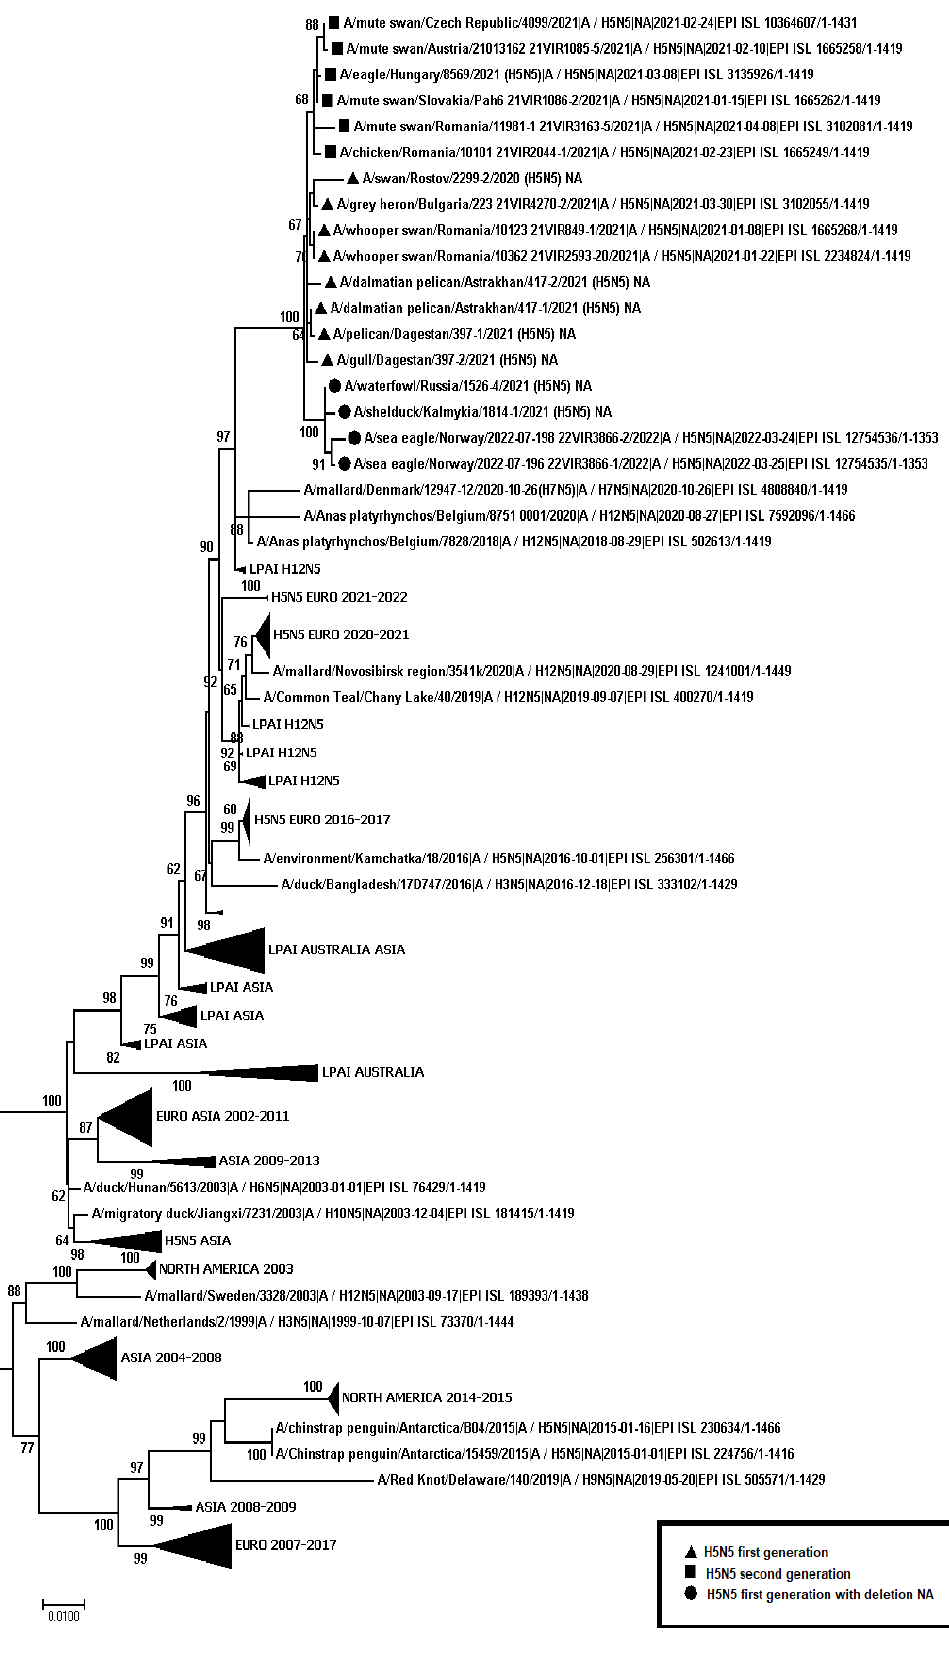
Figure 4. Phylogenetic tree constructed using the NJ method, based on the nucleotide sequence of the NA gene fragment (1–1419 bp ORF) of AIV subtype N5.